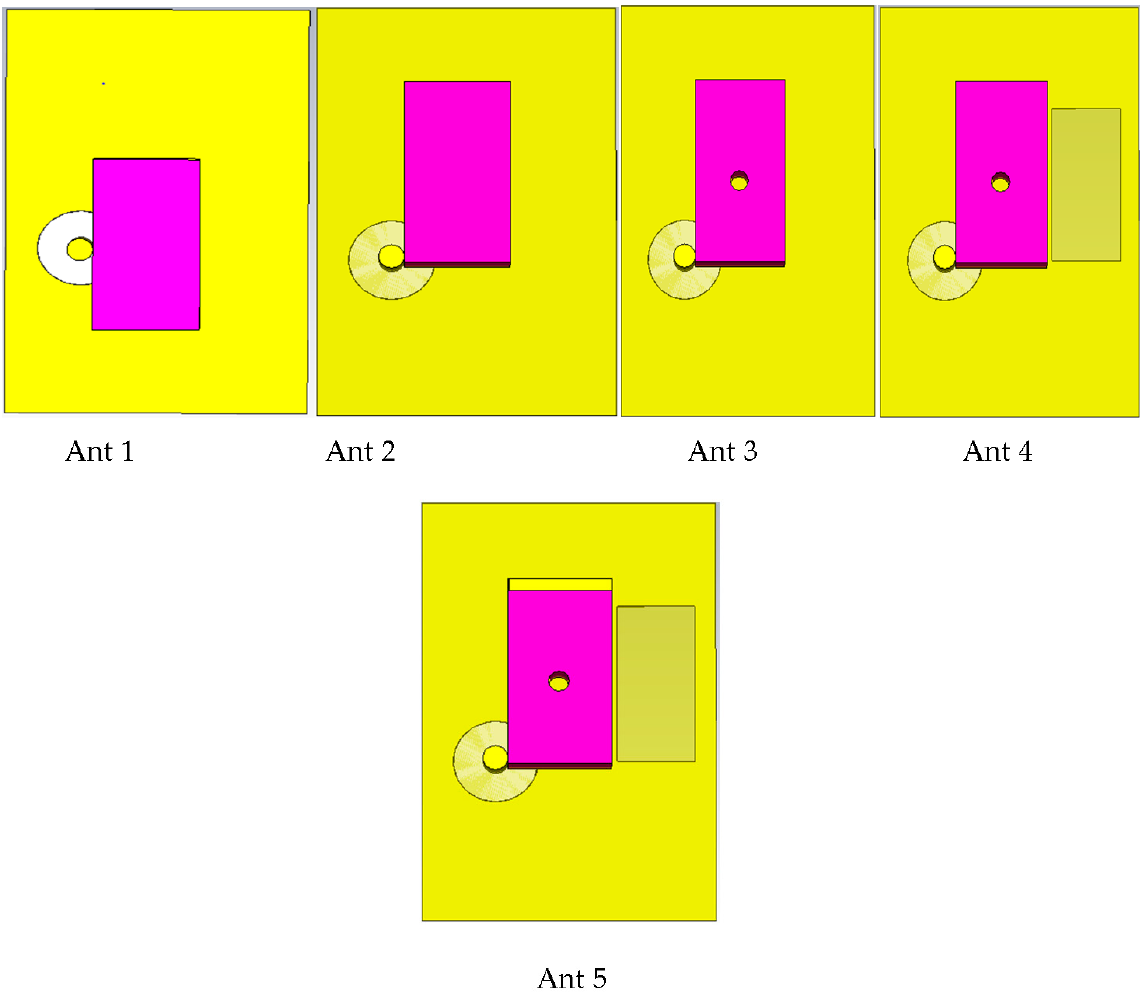
Figure 2. Design steps of the proposed antenna.